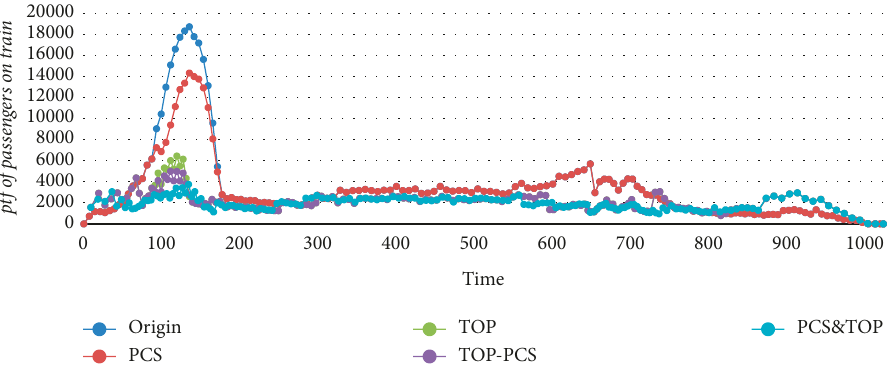
Figure 15: Platform waiting time of passengers at each train on Line 4 in different solutions.